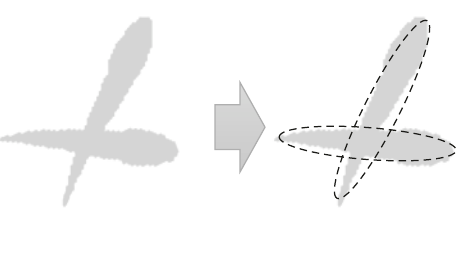
Figure 2: Fitting individual fishes from occlusions.